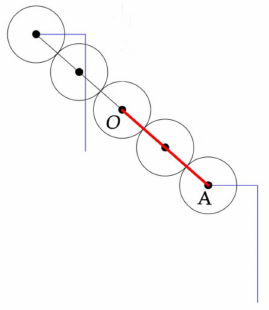
Figure 4. Sketch of full spur gear planetary